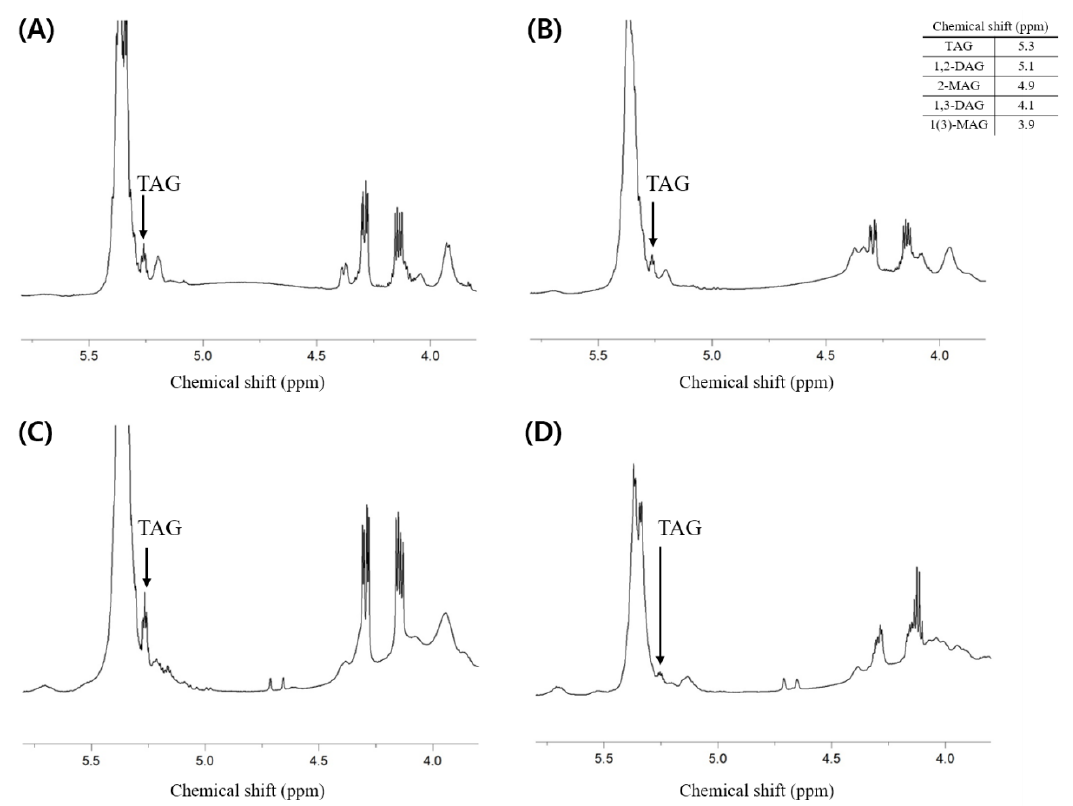
Figure 4. 1 H-NMR spectrum of total lipid extracted from the dried big head shrimp, opossum shrimp, mussel, and sea cucumber. ( A ) Dried big head shrimp; ( B ) Dried opossum shrimp; ( C ) Dried mussel; ( D ) Dried sea cucumber.